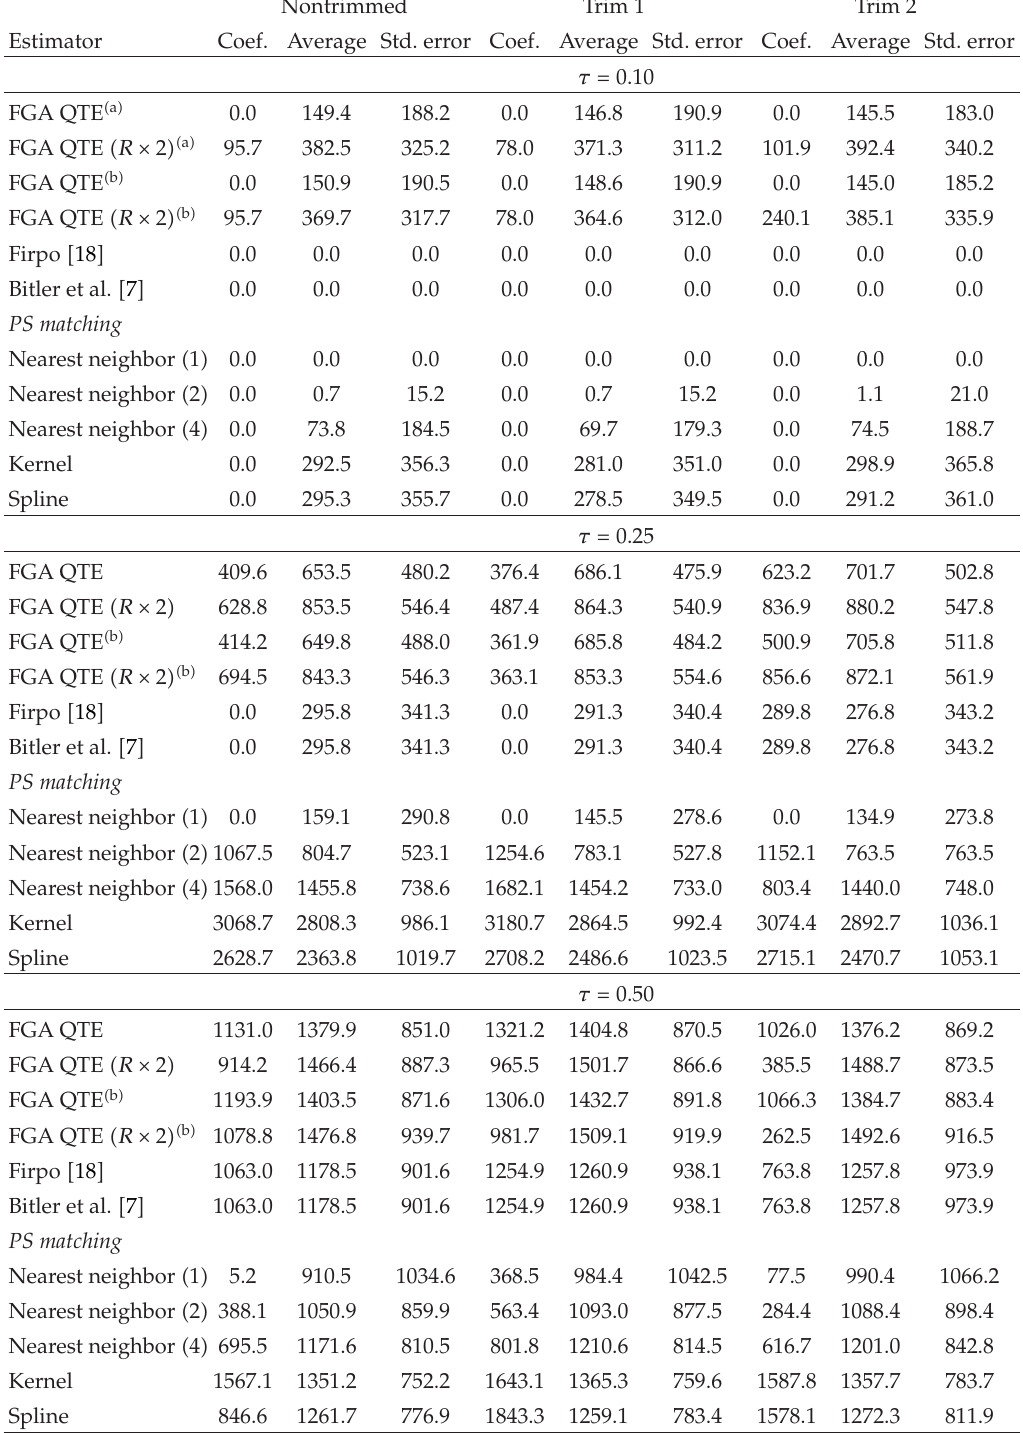
Table 4: QTE estimators of the e ff ect of training on earnings. Nontrimmed Trim 1 Trim 2